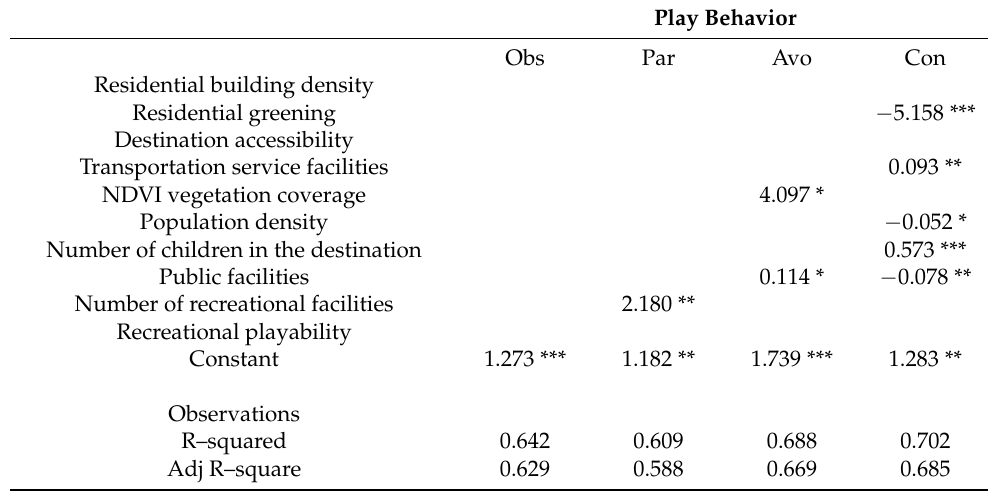
Table 7. The impact of urban built environment on play behavior of children with